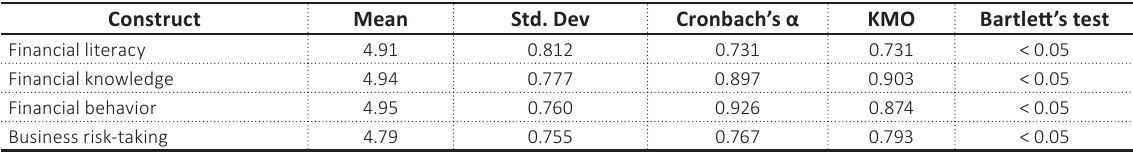
Table 1. Validity and reliability of